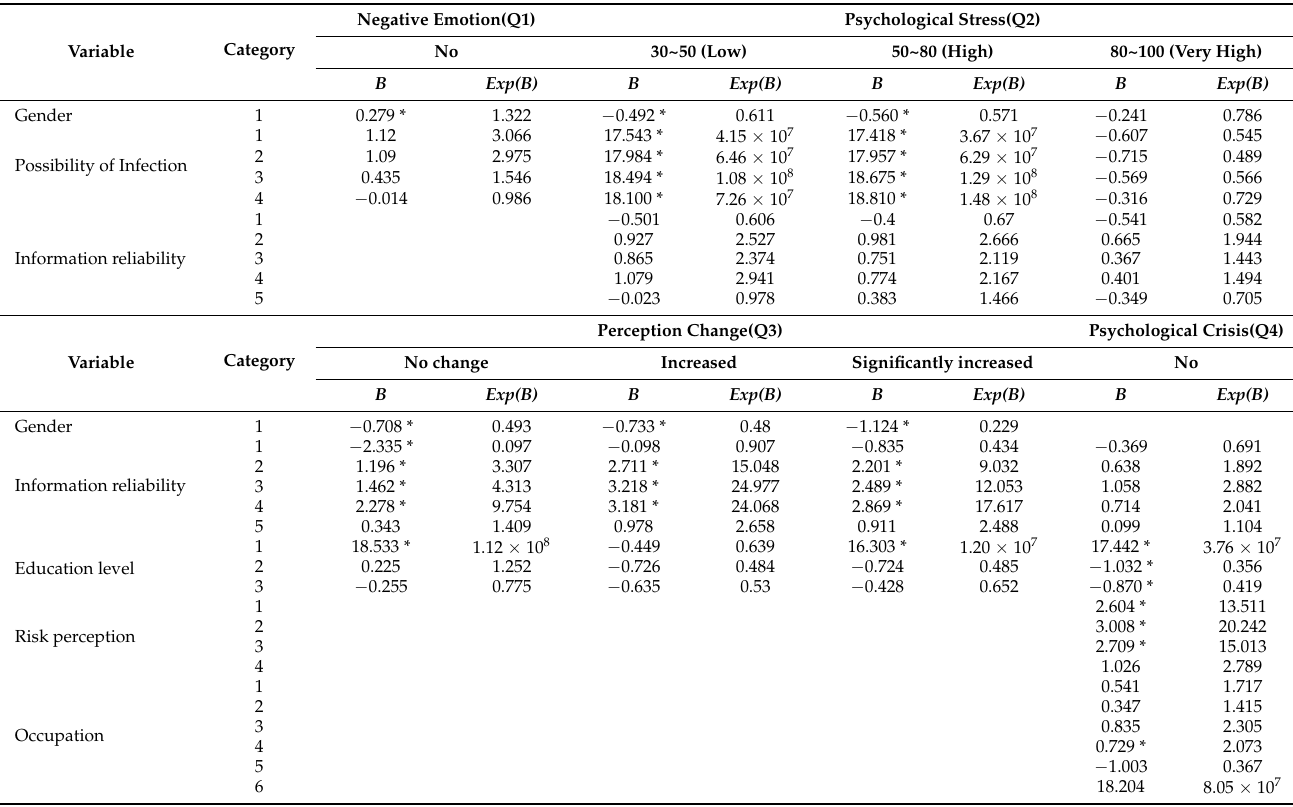
Table 4. The simulation results of multinational logistic